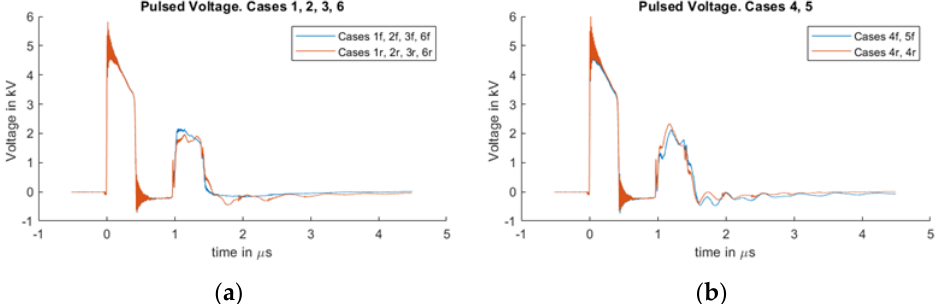
Figure 4. The measured voltage at the voltage pulse generator. The signal from 0 to 0.3 µ s belongs to the outgoing pulse; the signal after 0.8 µ s is the reflected voltage at the HVDC connection. ( a ) Measured voltage for cases 1, 2, 3 and 6. ( b ) Measured voltage for cases 4 and 5.